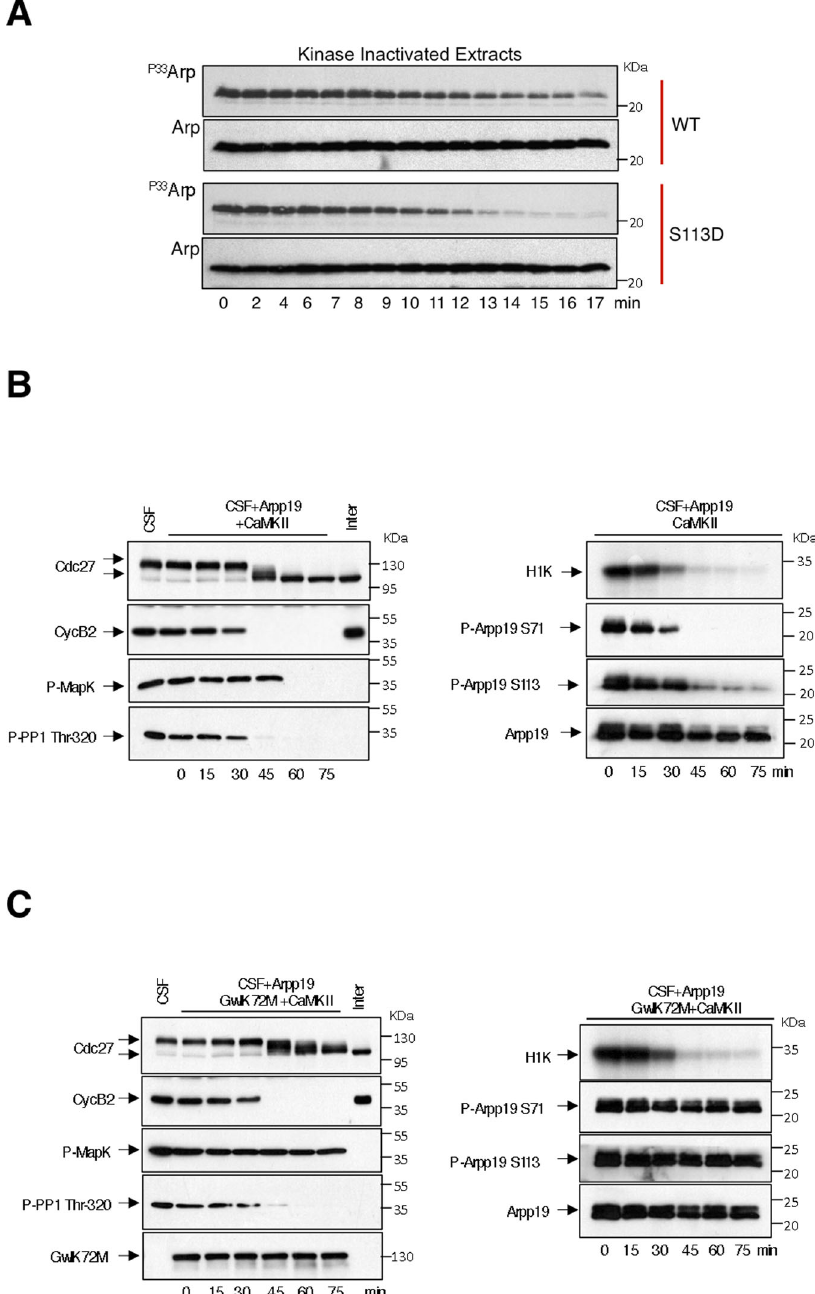
Fig. 6 Phosphorylation of S109/S113 modi fi es the temporal pattern of S67/S71 dephosphorylation. A Wild type and S109/S113D Arpp19 mutant were phosphorylated ‘ in vitro ’ with of [ γ 33 P] ATP by GwlK72M on S67/S71 and supplemented to kinase-inactivated Xenopus egg extracts. The dephosphorylation of this residue was analysed at the indicated times by autoradiography ( P33 Arp) and the amount of Arpp19 in each sample measured by western blotting (Arp). B CytoStatic Factor (CSF) egg extracts were supplemented with a trace level of Arpp19-puri fi ed protein and activated to exit meiosis by the addition of active CamKII. The levels and dephosphorylation of the indicated proteins were analysed by western blotting, whereas Cyclin B/ Cdk1 activity was measured by histone H1 phosphorylation (H1K). ‘ Inter ’ denotes interphase egg extracts. C As for C , except that S67/S71 Arpp19 dephosphorylation and PP2A-B55 reactivation upon meiosis exit in these extracts was blocked by the concomitant addition of GwlK72M-puri fi ed